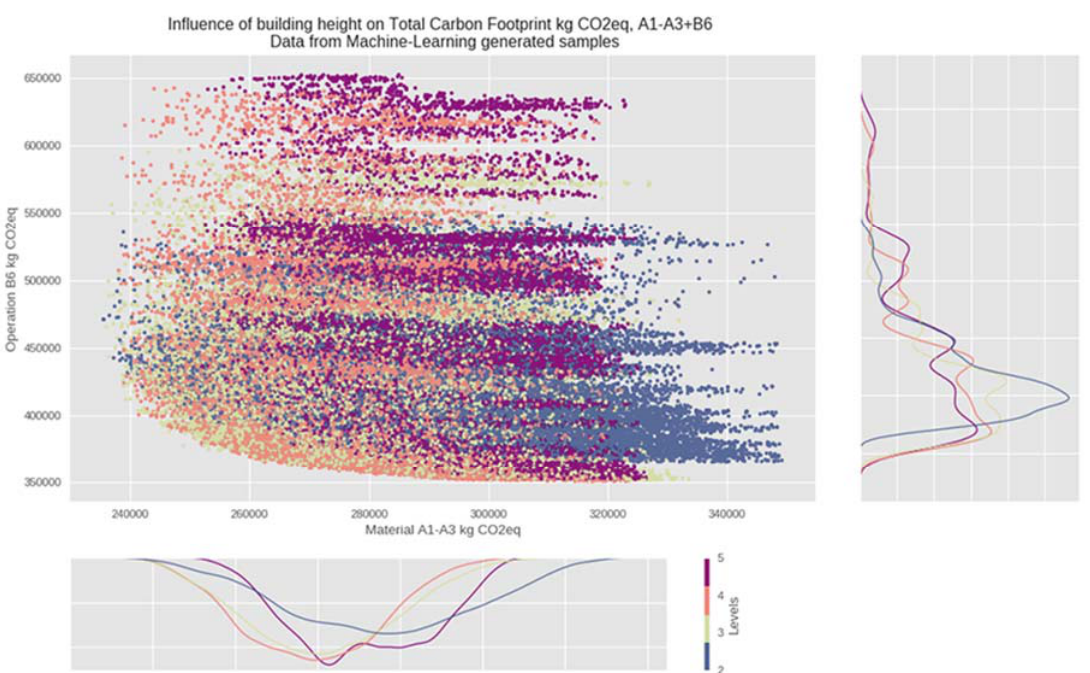
Figure 5. Scatterplot of Carbon Footprint with the coloring based on the building levels. The plot shows that lower buildings feature higher Embodied Carbon, while higher buildings feature higher Embodied Carbon, the optimal building height is nor the highest nor the lowest possible.